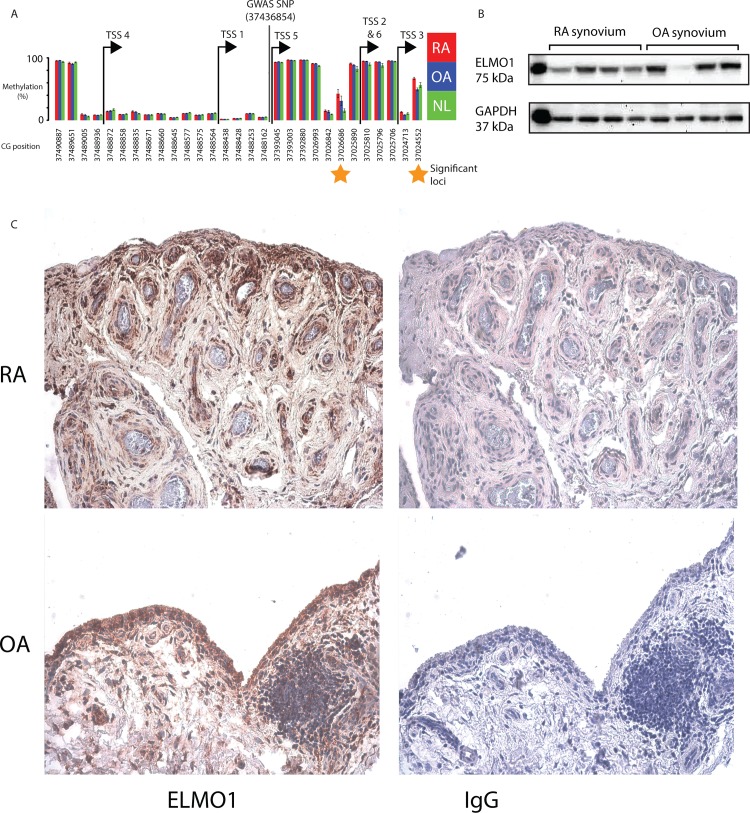

ELMO1 methylation and expression in RA FLS and synovium.(A) A summary of DNA methylation at the ELMO1 promoter regions from our previous study of FLS [4] and the location of the ELMO1 RA GWAS SNP. The methylation levels of each of the CGs on the bead array that are within the ELMO1 promoter region (-2500bps to +500bps from TSS) are shown. Error bars represent the standard error of the mean (SEM) and stars highlight significantly differentially methylated CGs. The locations of the TSSs are indicated with arrows and the transcript variant numbers of the RefSeq genes that are transcribed from that TSS are shown. Comparisons are shown between RA, osteoarthritis (OA) and normal (NL) FLS. (B) Western blots showing the expression of and GAPDH in RA and OA synovial tissue. First lane shows positive control, and subsequent lanes show ELMO1 protein levels in whole RA and osteoarthritis (OA) synovium (n = 4 each). There was no significant difference in overall ELMO1 expression. (C) Immunohistochemistry for ELMO1 expression in RA and OA synovial tissue. Note prominent staining in synovial intimal lining and sublining perivascular regions (brown color). Osteoarthritis synovium had a similar distribution. Left panels shows anti-ELMO1 antibody. Right panels shows control IgG. Tissues were lightly counterstained with hematoxlin. Original image at 200x magnification.